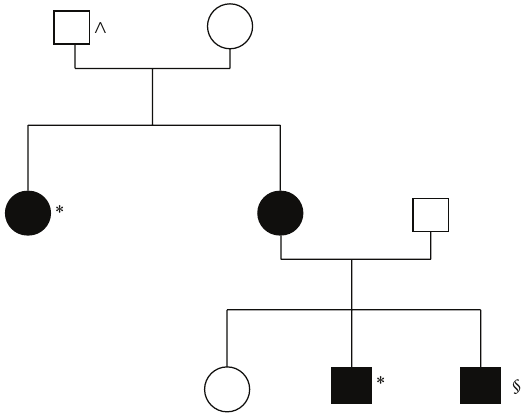
Figure 3: The patient’s family tree. Black = affected by BHD syn- drome, presence of c.1285dup mutation in the FLCN; ∧ = possible BHD syndrome, genetic testing not available; ∗ = being symp- tomatic for pneumothoraces; § = being symptomatic for renal